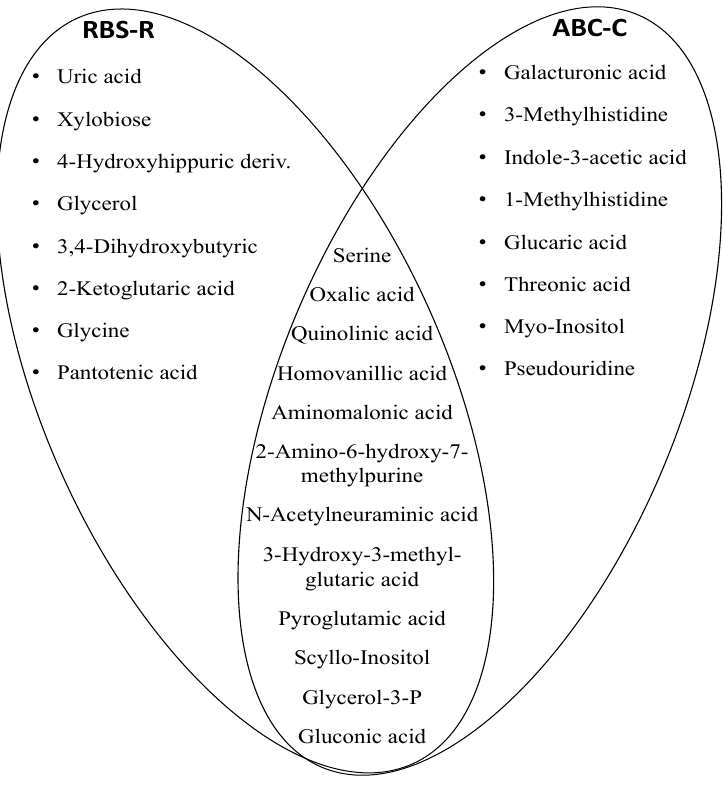
Figure 5. Venn diagram illustrating the top 25 metabolites shared between groups and discriminant ASD children with severe impaired behaviors from those with mild-to-moderate impaired behaviors. The visualization of the common metabolic content is suggestive to the presence of the perturbed pathways such as oxidative stress, gut dysbiosis and purine metabolism. The most perturbed pathways shared by the two scales (RBS-R and ABC-C) were glycine, serine, and threonine metabolism, tryptophan metabolism, oxidative stress, mitochondrial energy supply, and purine metabolism. Table 5. Statistical parameters of the OPLS-DA models derived from the GC-MS spectra of urine samples. Autistic children with severe abnormal behaviors (either with RBS-R or ABC scores above the cut-o ff limit) were compared with autistic children with mild-to-moderate abnormal behaviors (either with RBS-R or ABC scores below the cut-o ff limit).